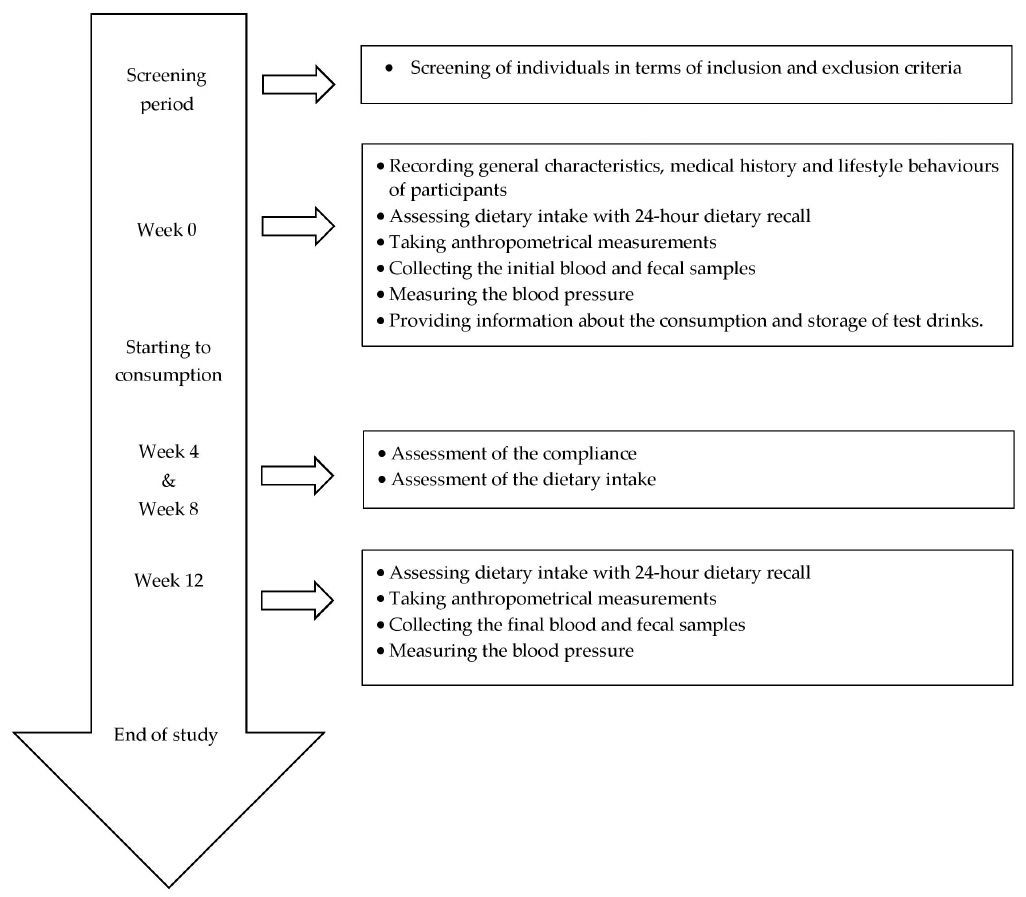
Figure 1. Timeline of the study.